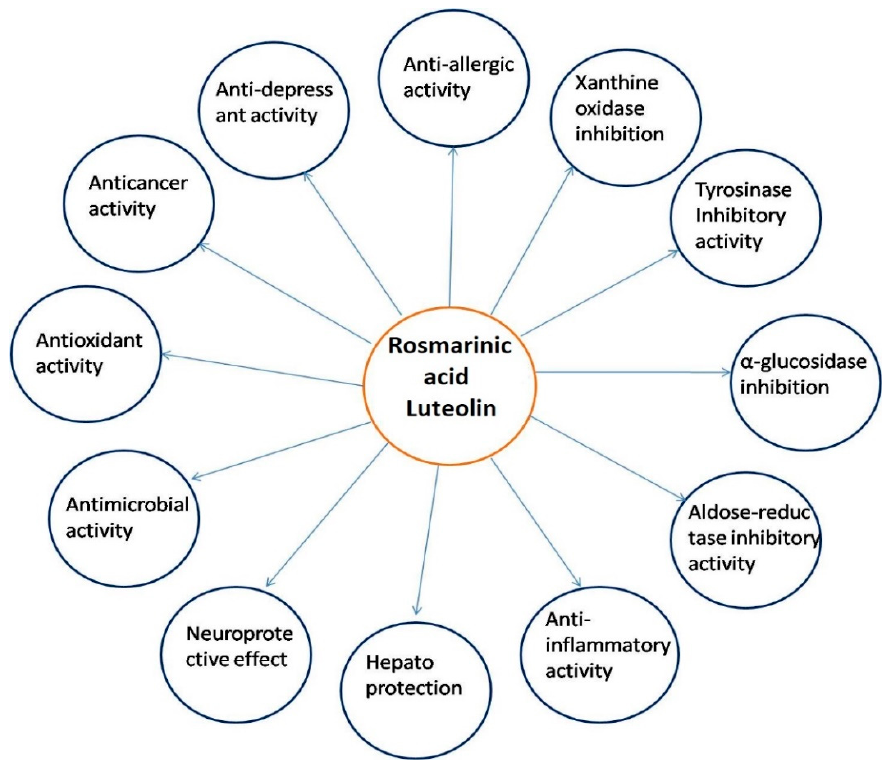
Figure 5. Different biological functions of rosmarinic acid and luteolin, reported from P. frutescens.